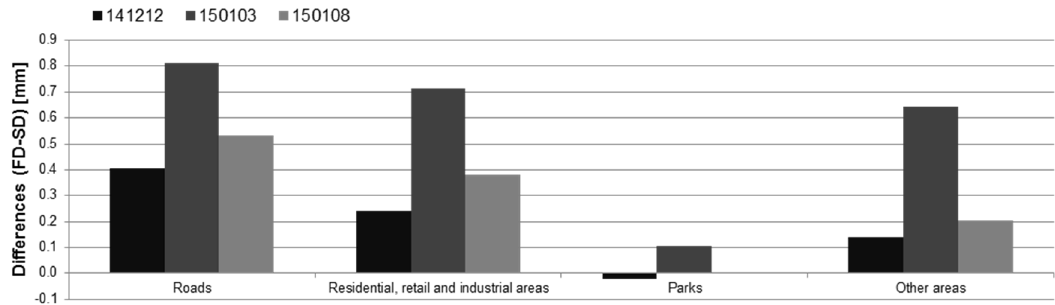
Figure 7. Differences between runoff volumes on the overland surface generated by SD and FD models, distributed by land use groups in Cranbrook case study. The bars correspond to the three storm events under consideration (see Table 1).